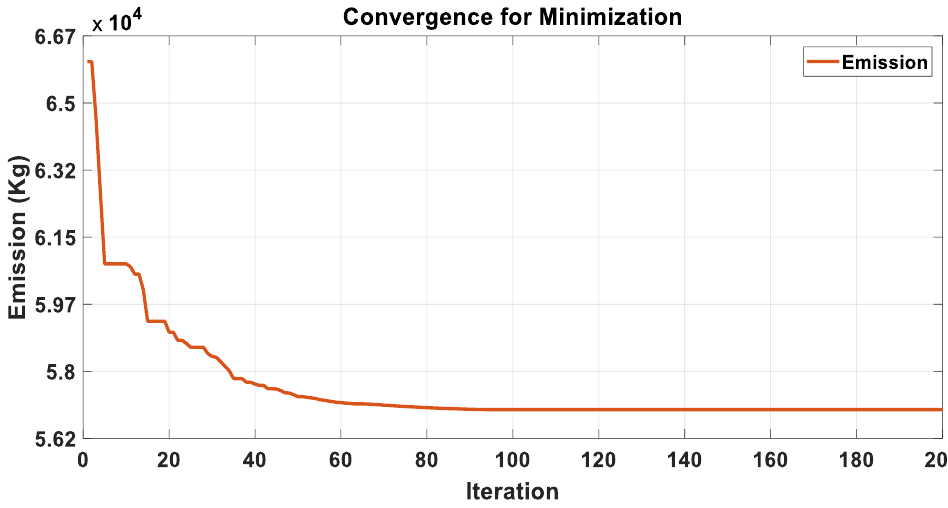
Figure 13. Convergence characteristics of the MOBWO algorithm for Case II.